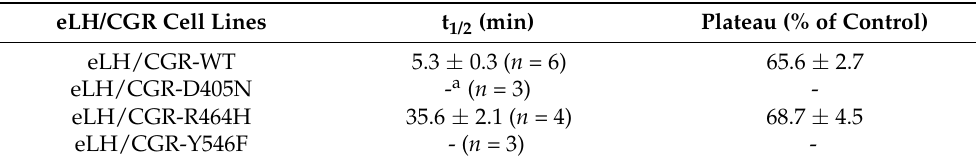
Table 4. Rates of cell-surface loss of receptors in transient transfected cell lines expressing the wild-type eLH/CGR and mutants